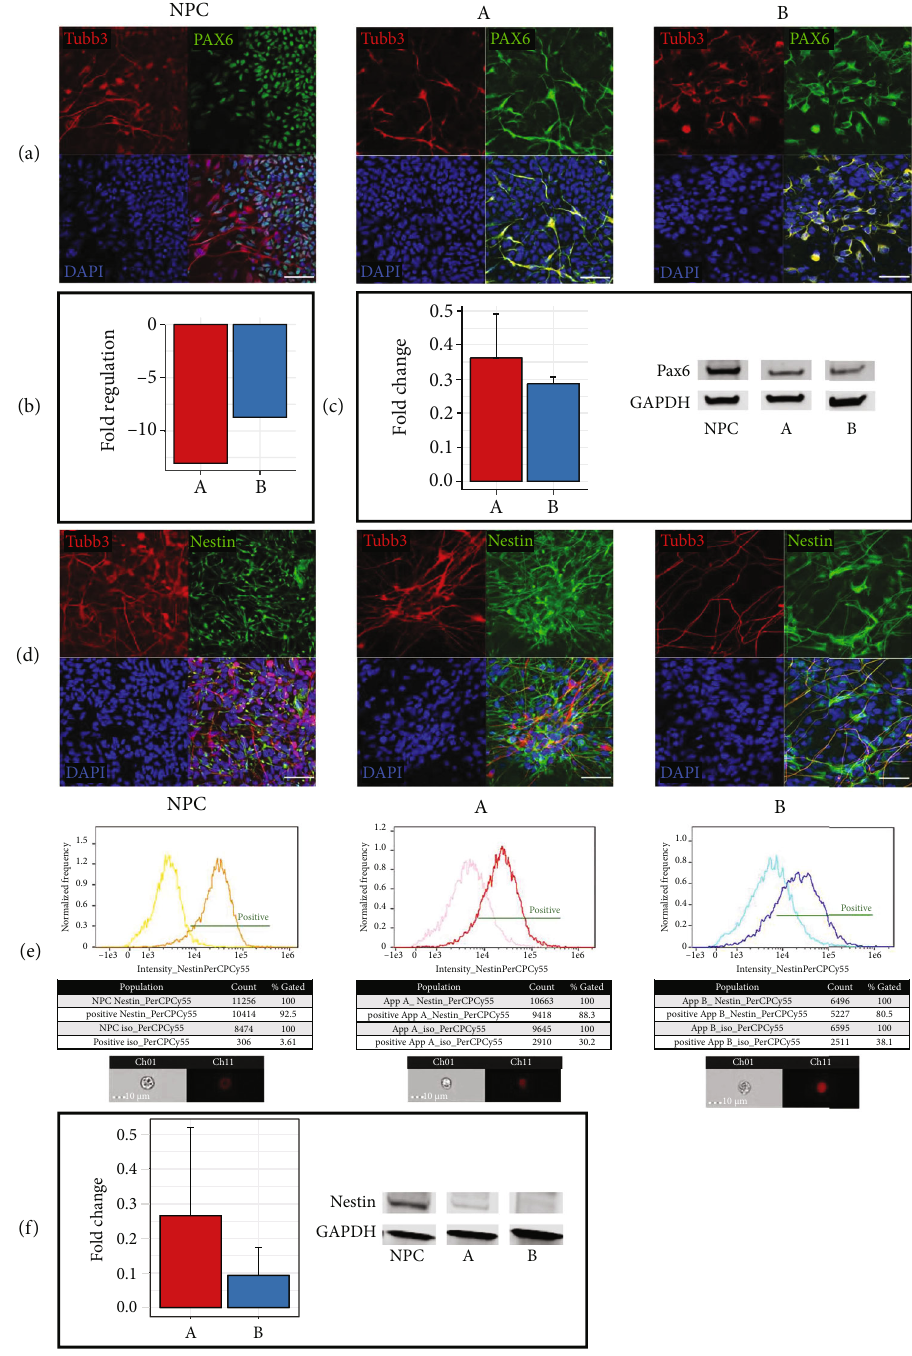
Figure 4: Early neuronal di ff erentiation markers. (a) Representative confocal fl uorescence microscopy images showing Pax6 (green) staining in the nuclei of NPC and Tubb3 (red) staining in the axons of all three approaches. Cell nuclei were counterstained with DAPI (blue). (b) Downregulation of Pax6 was detected by qRT-PCR in approaches A and B ( n = three independent experiments). See Figure 3 for all results. (c) Decreased Pax6 protein expression was observed in Western Blot, shown in representative bands ( n = three independent experiments). Each bar represents the fold change mean ± Standard Deviation (SD). (d) NPC and neurons of approach A and B show persistent Nestin (green) and Tubb3 (red) expression detected by immuno fl uorescence. Cell nuclei were counterstained with DAPI (blue). (e) Decreased Nestin expression was detected in approaches A and B by fl ow cytometry and (f) by Western Blot, shown in representative bands ( n = three independent experiments). Each bar represents the fold change mean ± SD . All scale bars, 50 μ